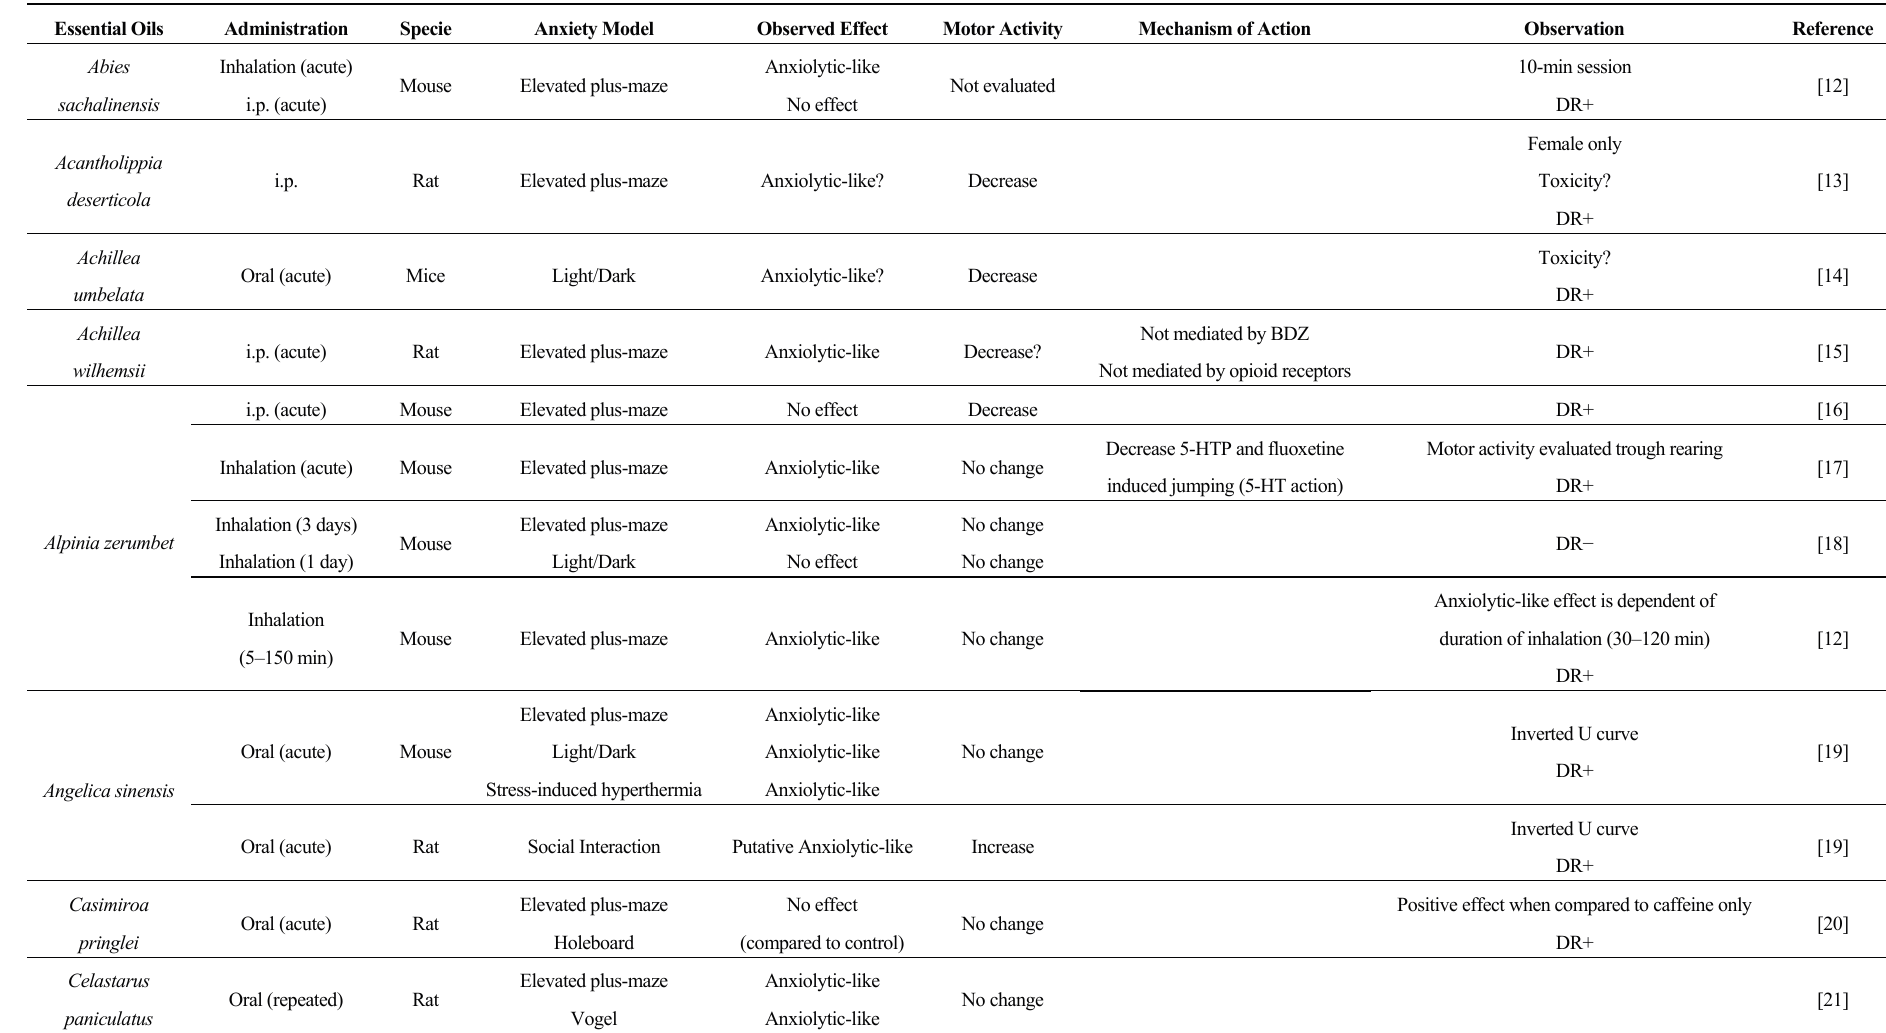
Table 1. Summary of studies with essential oils in animal models of anxiety (only essential oils with at least one positive result are included). Essential